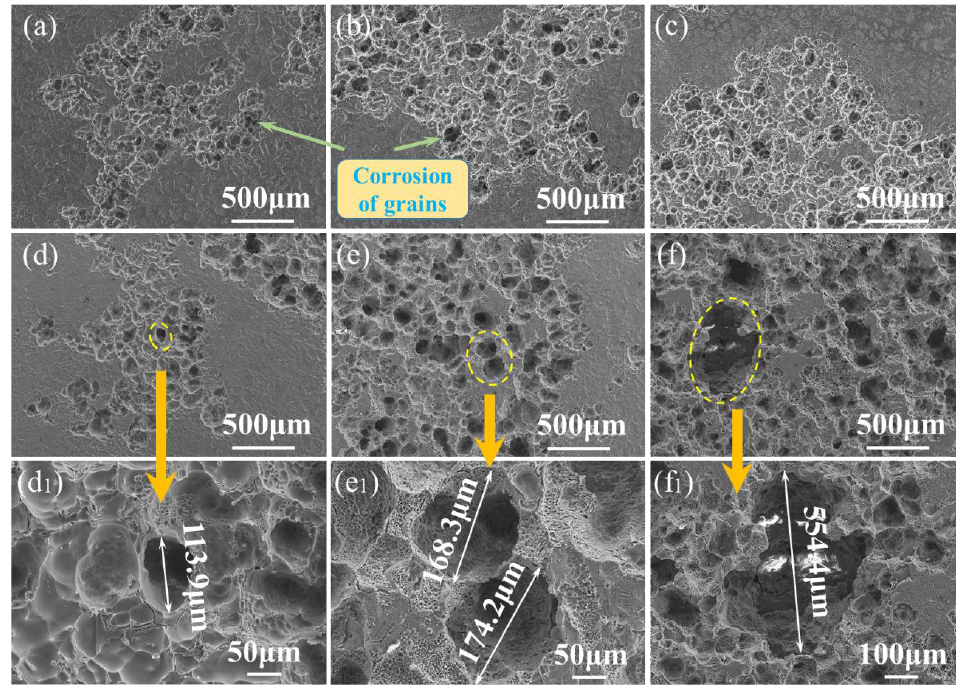
Figure 7. Surface morphologies after removal of the corrosion products with various immersion times in Hank’s solution of the ZM-xCa alloys: ( a – c ) ZM-0.1Ca, ZM-0.3Ca and ZM-0.5Ca alloys immersed for 7-day; ( d , d 1 ), ( e , e 1 ) and ( f , f 1 ) ZM-1.0Ca alloy immersed for 3-day, 7-day and 14-day, respectively.